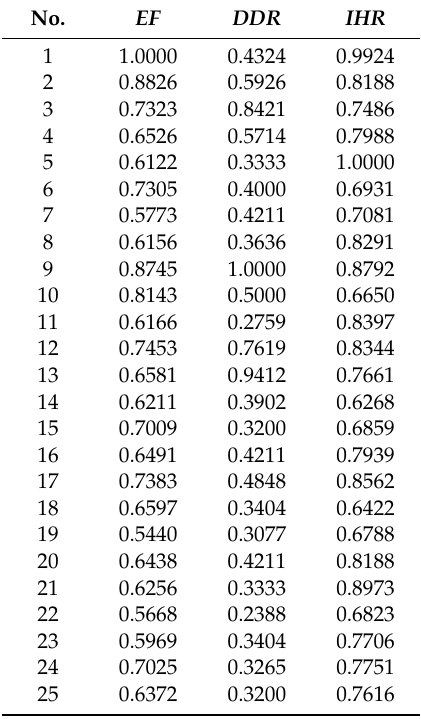
Table 6. Normalized results of machining